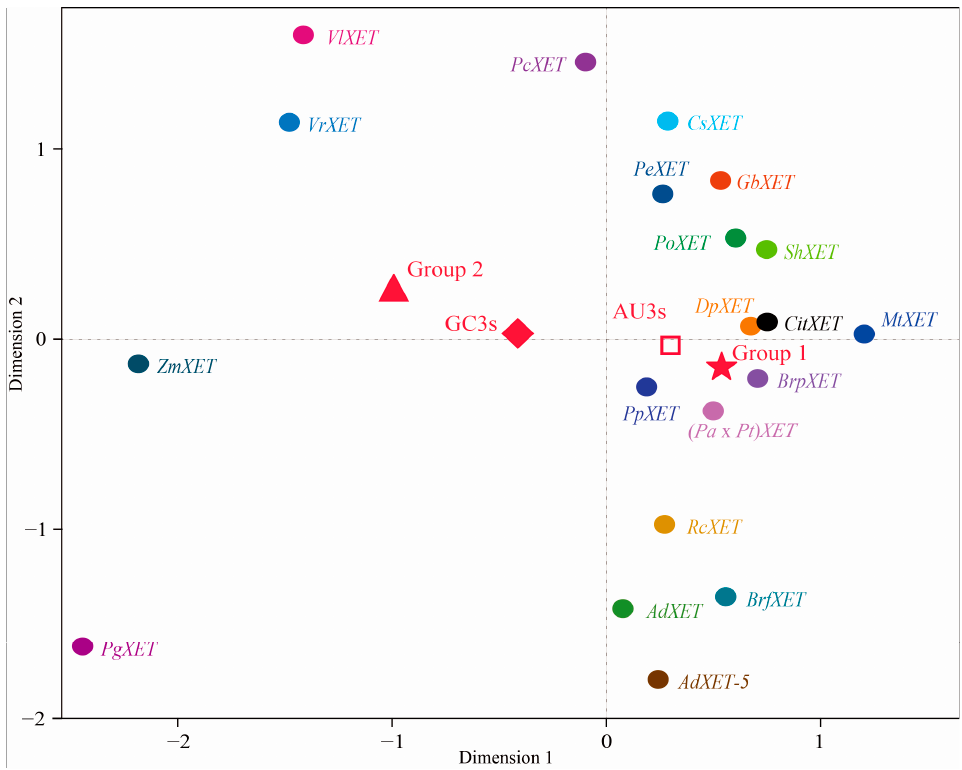
Figure 6. Multidimensional preference analysis of the relative synonymous codon usage for each codon of the 20 XET genes.